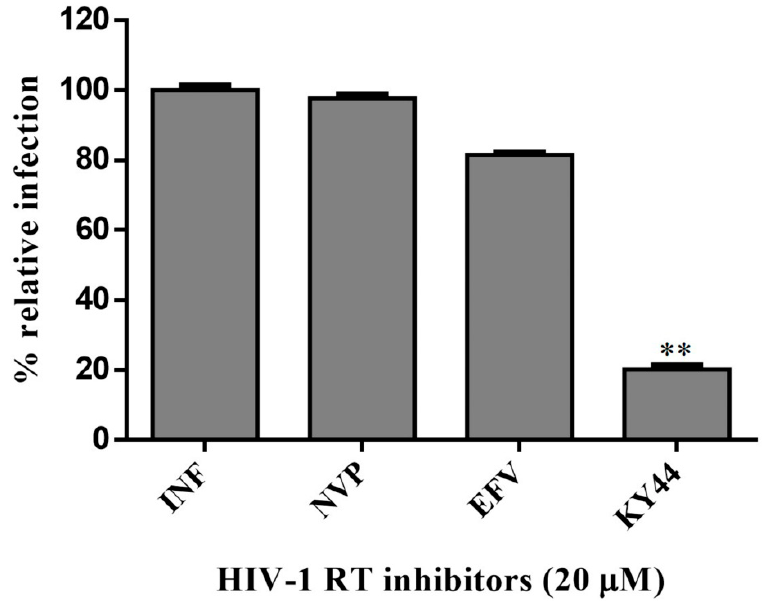
Figure 6. Percentage of the relative infection of pseudo-HIV-1 particles in HEK293 cells. Data are represented as the mean ± SD ( n = 3). ** is the significance of KY44 decrease when compared to EFV.